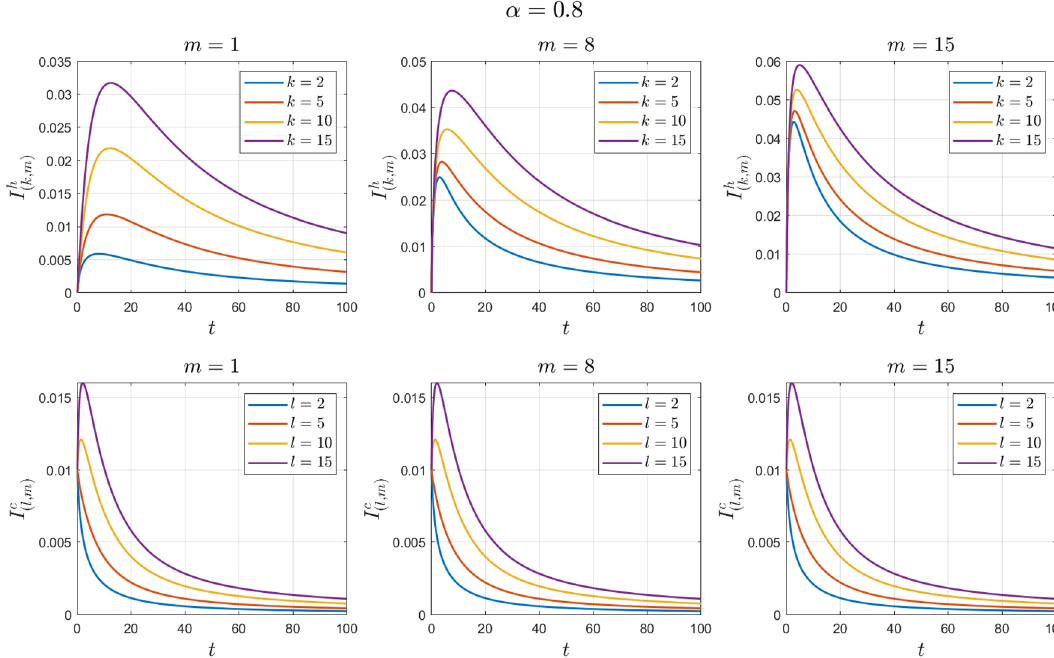
Figure 2. Numerical solutions of Example 1 for α = 0.8 .